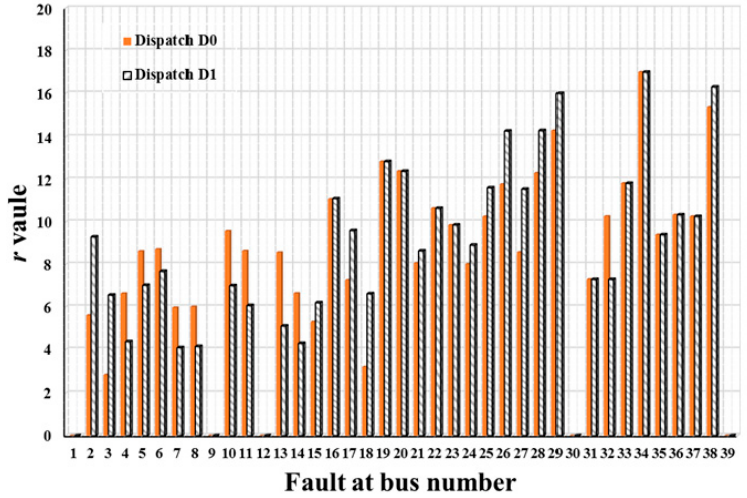
Figure 4. Comparison of local stability indices for dispatches D 0 and D 1 .